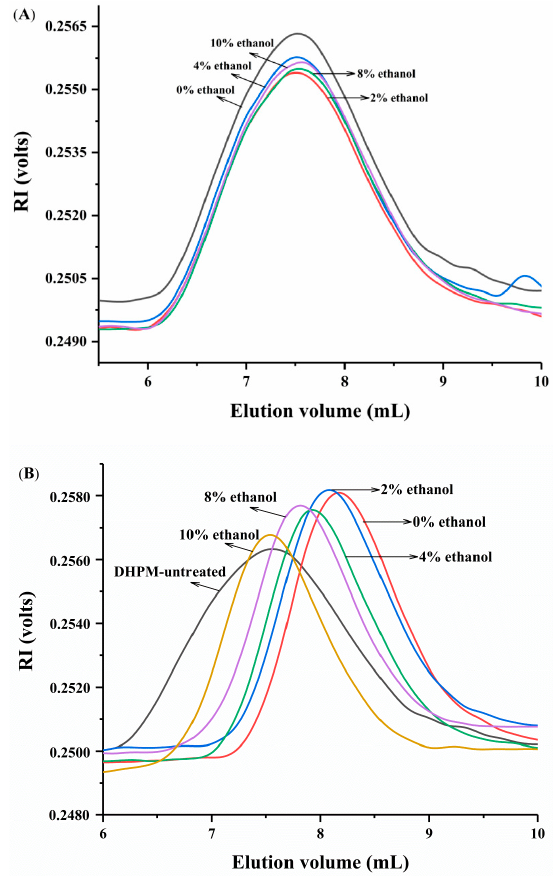
Figure 2. Average M w of pectin treated with ( B ) or without ( A ) DHPM under different ethanol concentrations.